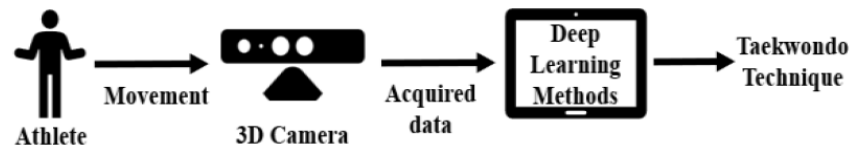
Figure 13. Deep-learning methods testing system diagram.